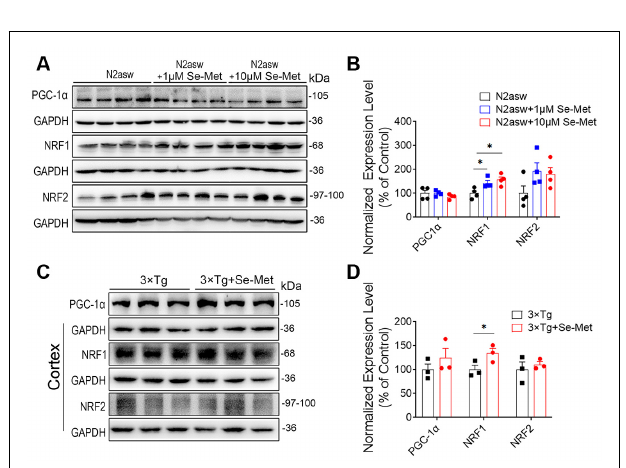
FIGURE 2 | Se-Met improved mitogenesis in both N2a-SW cells and AD mice. (A) The levels of PGC1, NRF1, and NRF2 in N2a-SW cells were detected by western blot analysis. (B) Quantitative analysis of these proteins ( ∗ p < 0.05 vs. the control group. n = 4). (C) The levels of PGC1, NRF1, and NRF2 in the cortices of AD mice were detected by western blot analysis. (D) Quantitative analysis of these proteins ( ∗ p < 0.05 vs. AD mice. n = 3 mice).